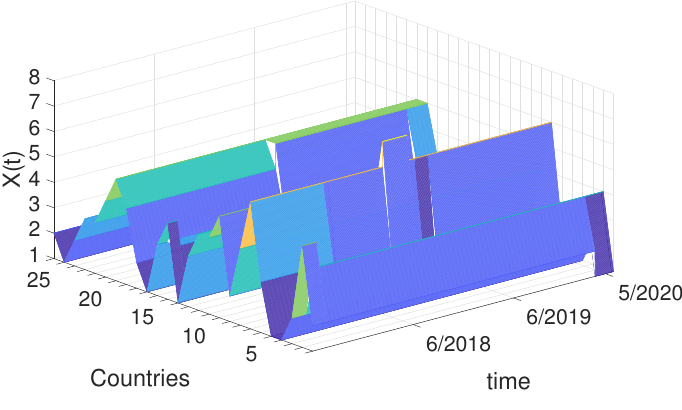
Figure 4. Simulation of the rating evolution with S&P data.